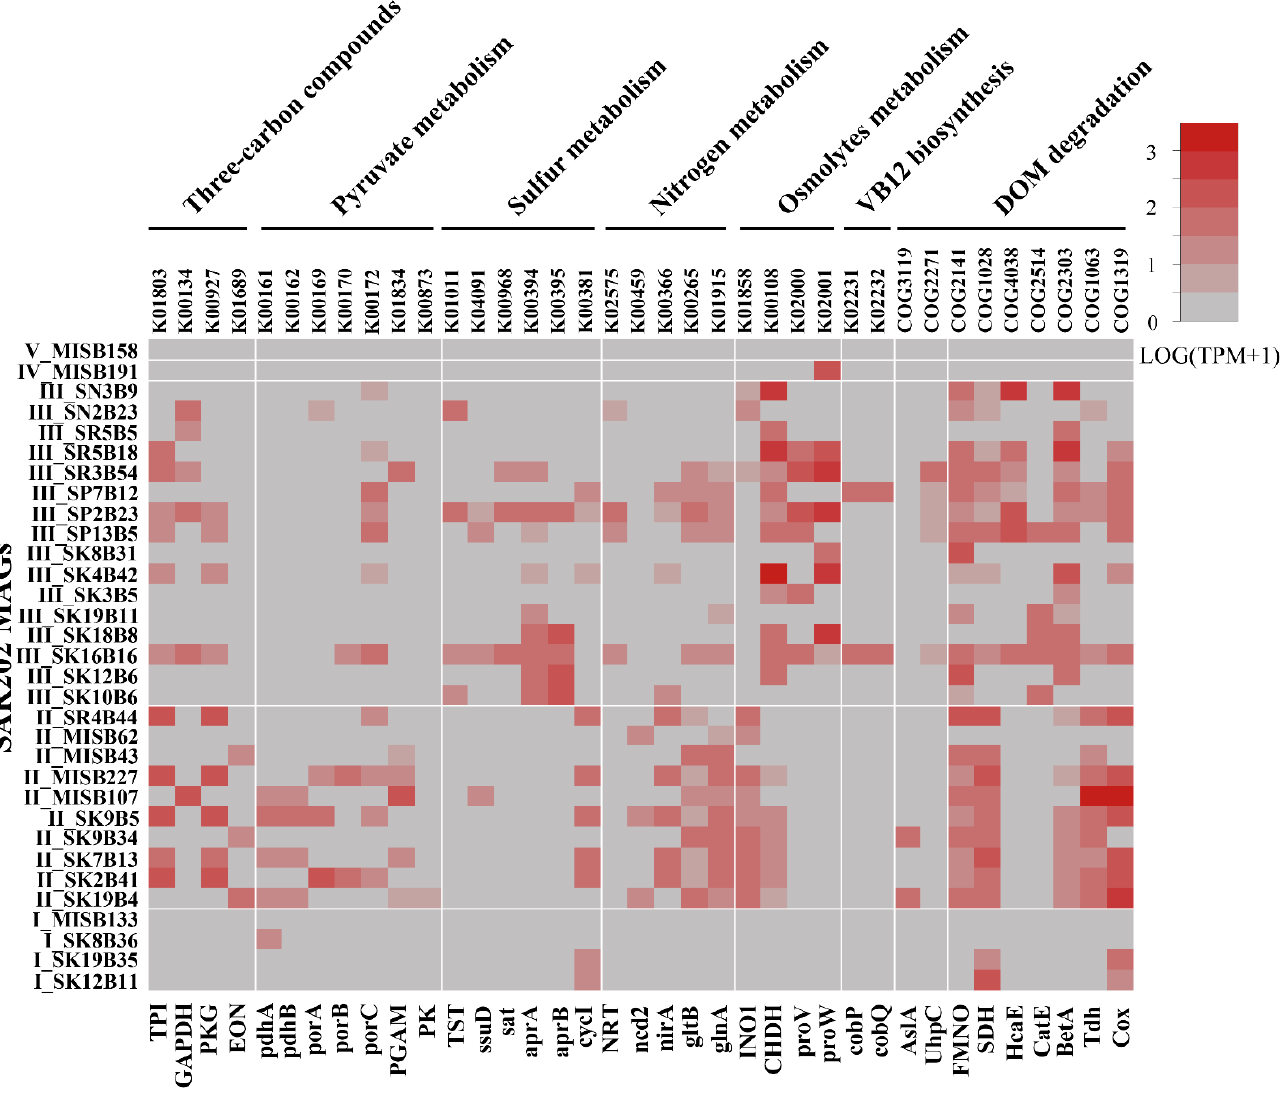
Figure 5. Transcriptional level of functional genes of SAR202 MAGs. For a functional gene, TPM values higher than 1 in three or more transcriptomic data from different time periods were averaged to estimate an overall transcriptional activity in a SAR202 species represented by the MAG. The gene names are shown in Table S5.